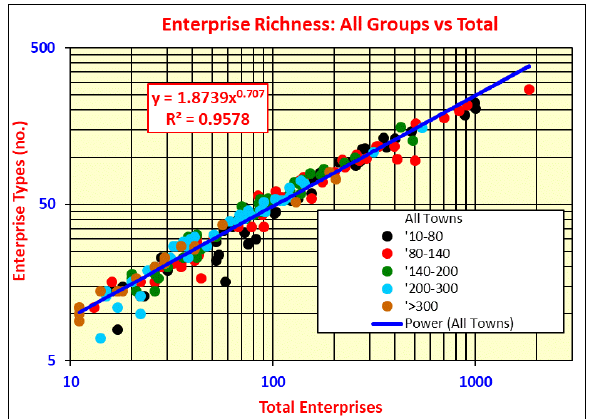
figure 3: The relationships between total enterprises and enterprise types of the different EDI groups in relation to the power law line of total enterprises versus enterprise types of all the selected towns.